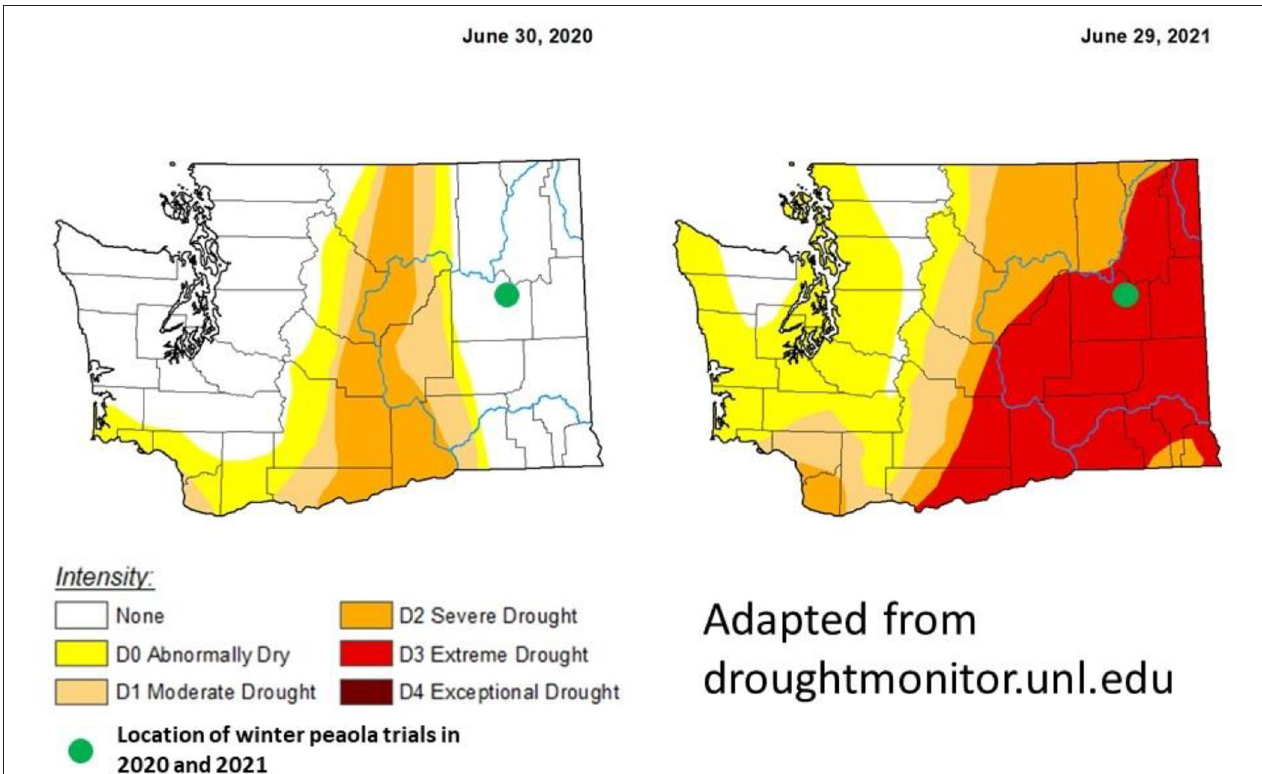
FIGURE 8 | Comparison the meteorological drought conditions from the last week of June in 2020 to the last week of June in 2021. The location of this trial in Davenport, WA, experienced a drought-free year during the 2020–2021 growing season. However, during the 2020–2021 growing season, Davenport experienced extreme drought. These maps were adapted from droughmonitor.unl.edu. The U.S. Drought Monitor is jointly produced by the National Drought Mitigation Center at the University of Nebraska-Lincoln, the United States Department of Agriculture, and the National Oceanic and Atmospheric Administration. Map courtesy of